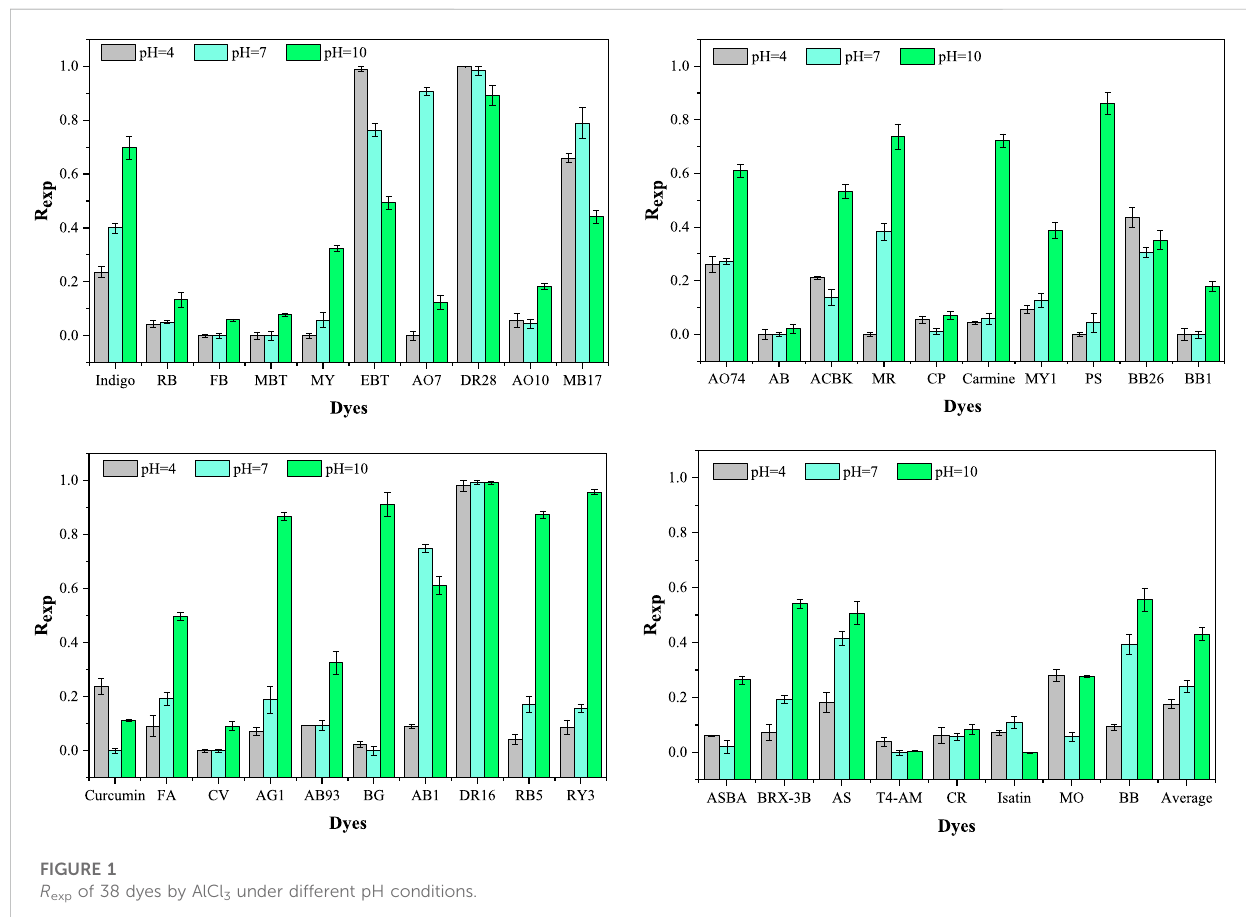
FIGURE 1 R exp of 38 dyes by AlCl 3 under different pH conditions.